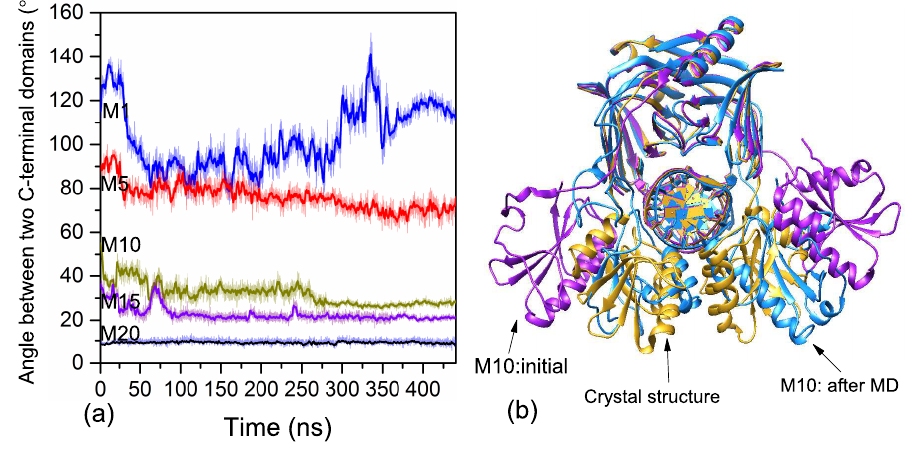
Figure 4. ( a ) The angles between two C-terminal domains of M1, M5, M10, M15, and M20 during long MD simulations. ( b ) The average structures during the last 2 ns, compared with the initial structure and active structure of M10. The initial structure of M10 is colored in purple; the crystal structure (the closed state) is colored in yellow; and the average structure after the MD simulation is colored in